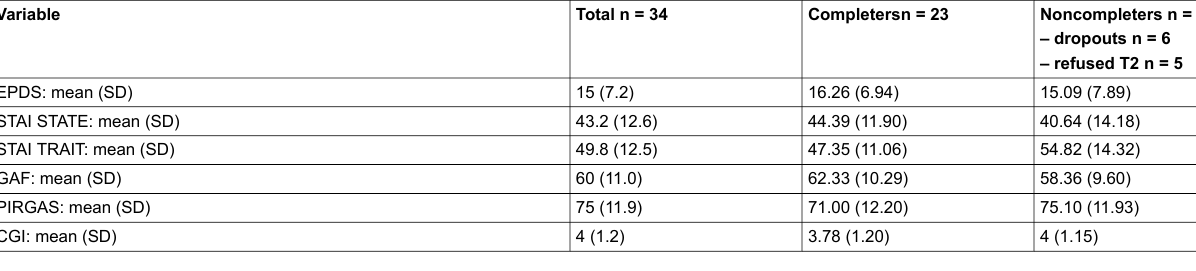
Table 2: Psychological characteristics for participants enrolled in the study (T1). Variable